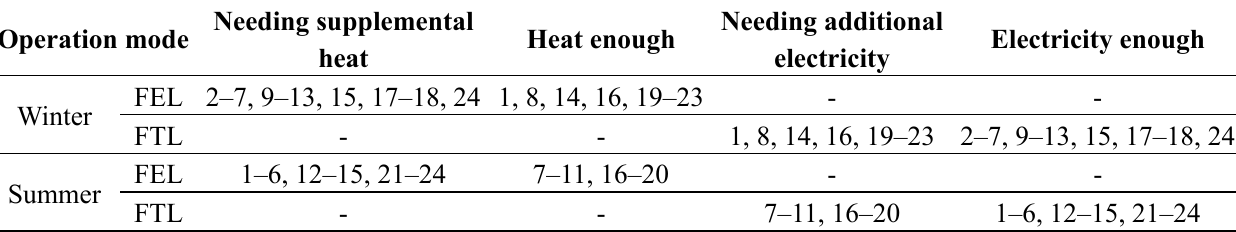
Table 3. Energy demand times for the hotel